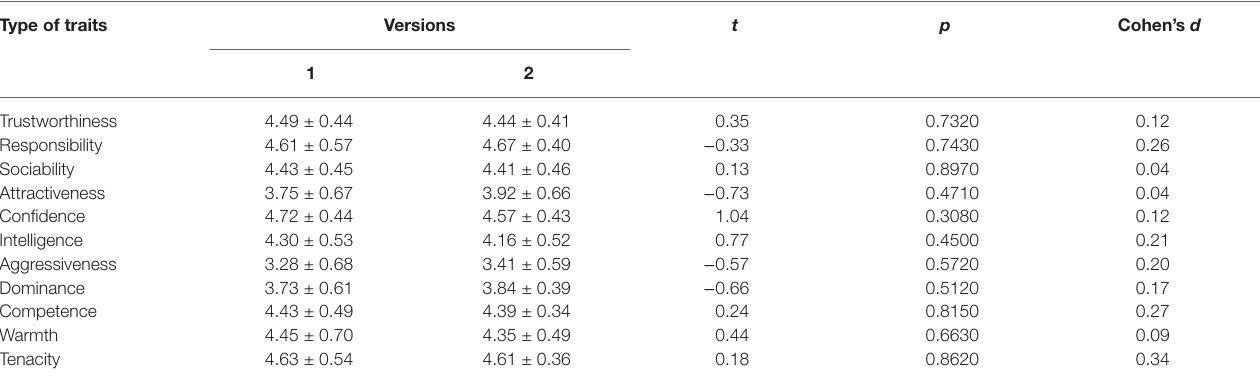
TABLE 9 | Evaluation scores for the different social traits under Version 1 and Version 2 (M ± SD). Type of